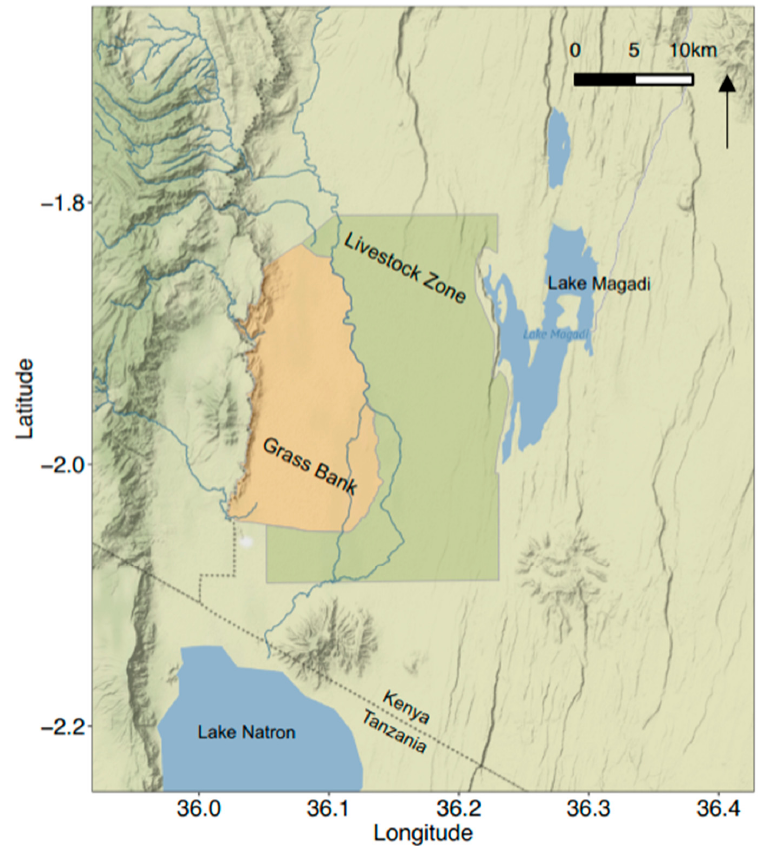
Figure 1. Map of the study area showing the livestock zone and grass bank grazing